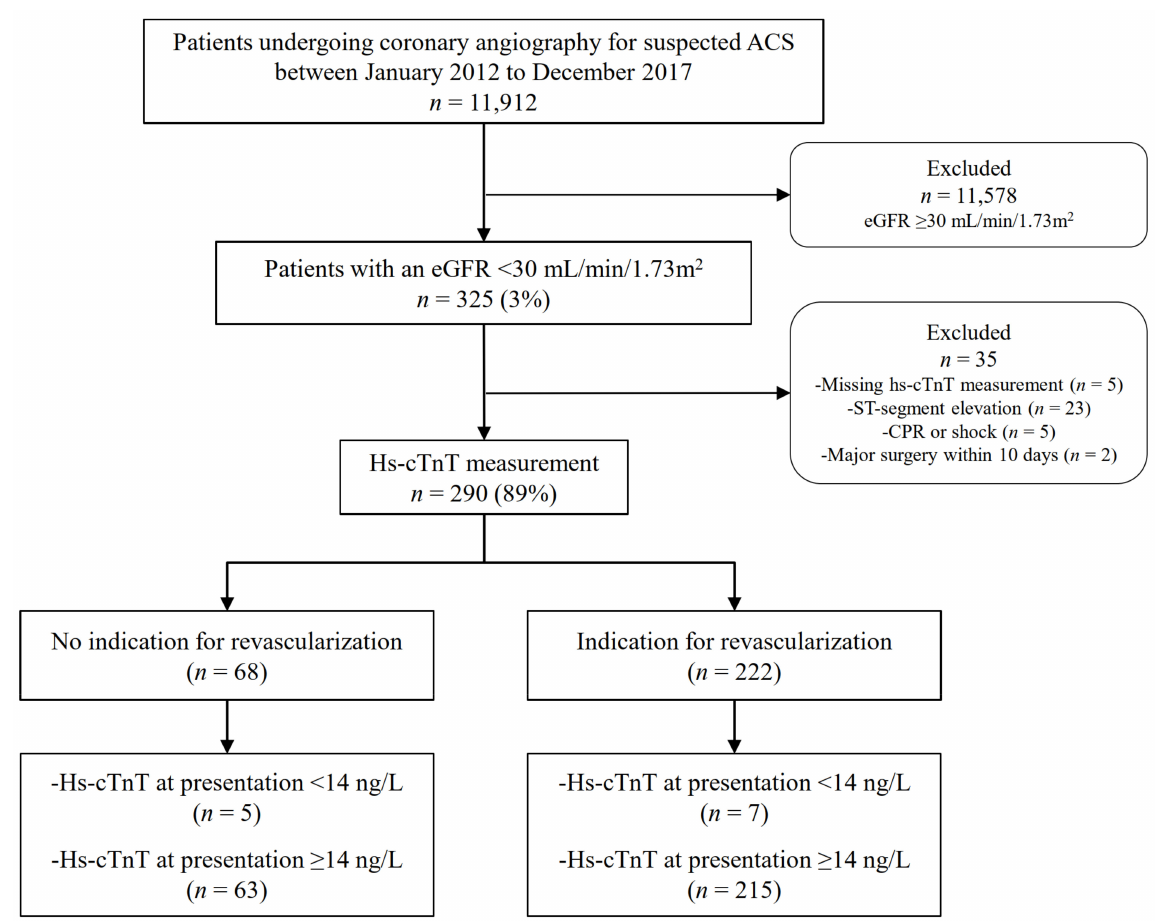
Figure 1. Flow chart of patient selection process. ACS, acute coronary syndrome; CPR, cardiopulmonary resuscitation; ED, emergency department; eGFR, estimated glomerular filtration rate according to the Chronic Kidney Disease Epidemiology Collaboration (CKD-EPI)